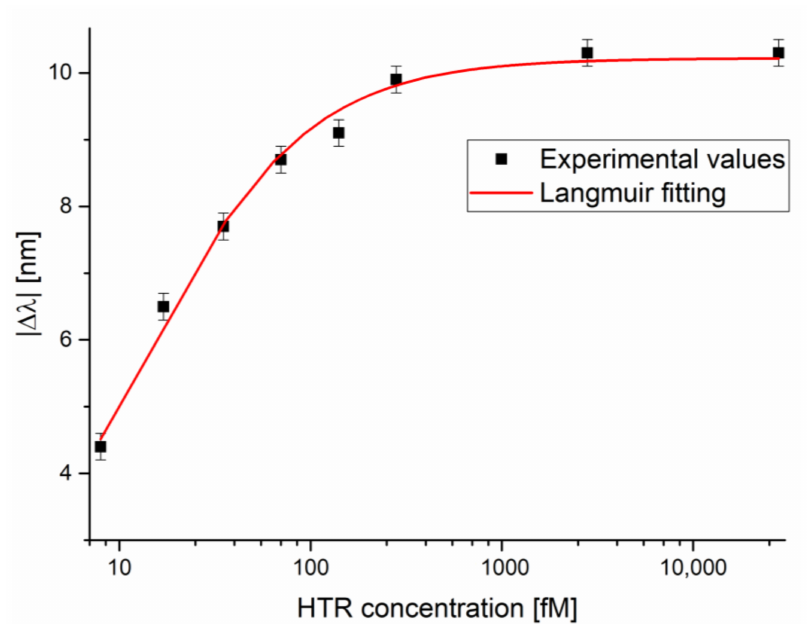
Figure 4. Absolute value of resonance wavelength variation (with respect to the blank) versus the HTR concentration, with the Langmuir fitting of the experimental values in a semi-log scale. Measurements were performed in